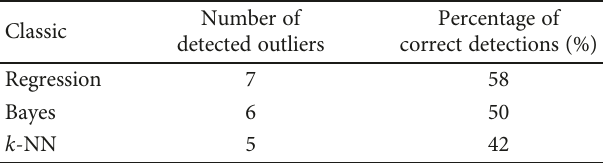
Table 1: Best results of outlier detection using classic methods.